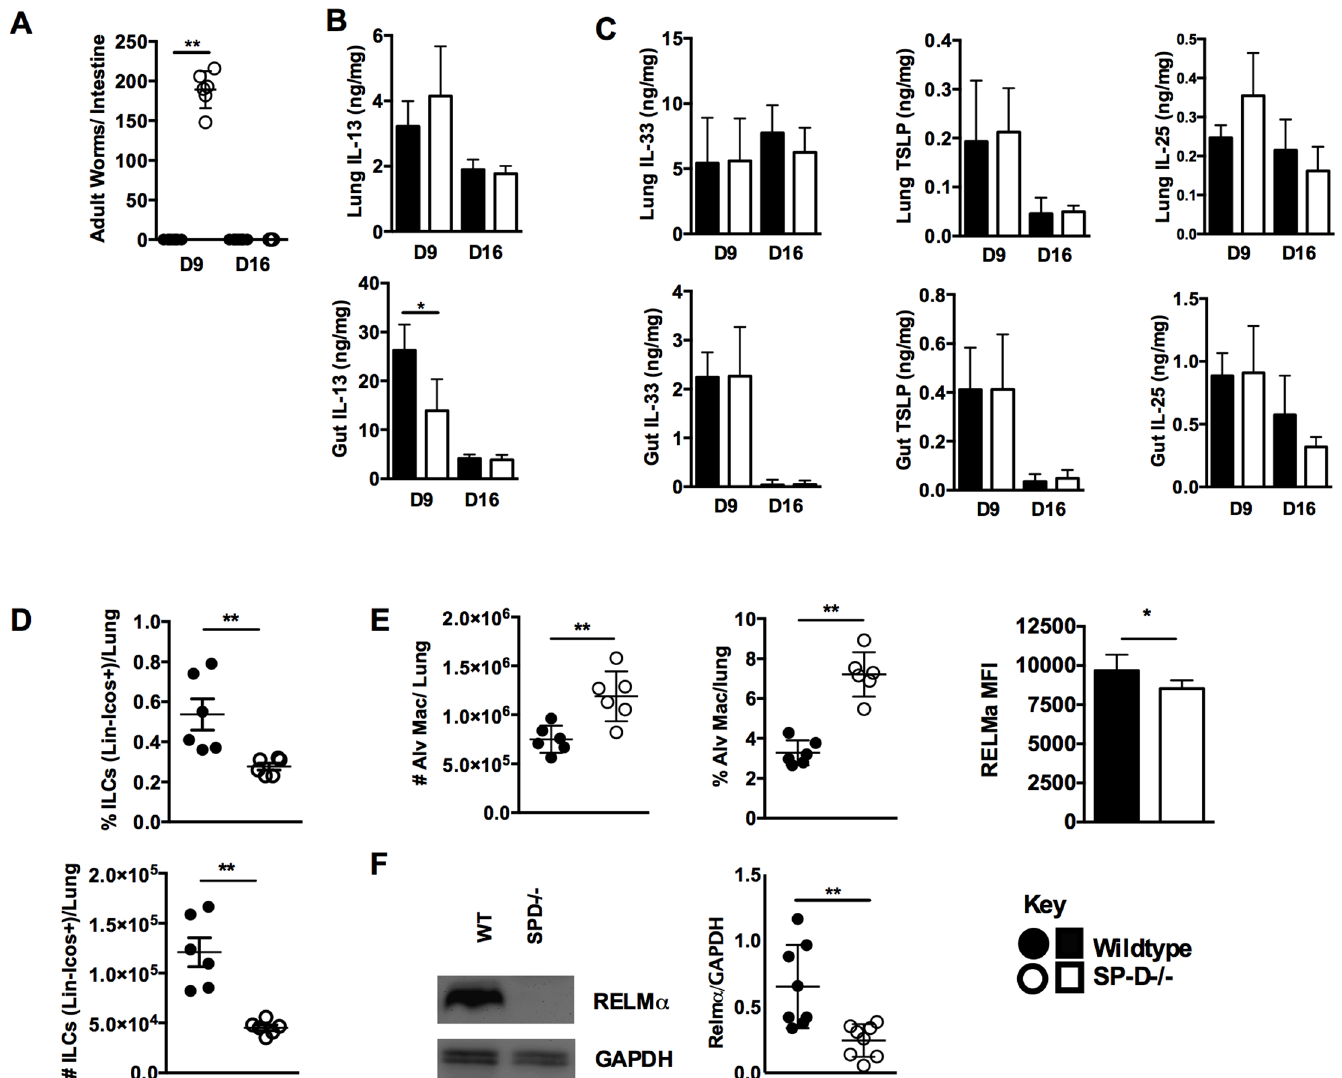
Fig 2. Immunity to N . brasiliensis is impaired in SP-D-/- mice. N . brasiliensis infected wild type and SP-D-/- mice were killed at days 9 and 16 PI. Intestinal worm burdens were quantified (a) . Levels of lung and intestinal tissue IL-13 (b) , IL-33, TSLP and IL-25 (c) were established by ELISA at days 9 and 16 PI. FACS analysis established proportions and total numbers of ILC (d) . Numbers and proportions of alveolar macrophage and mean fluorescence intensity (MFI) of RELM- α detection within this population (e). Relative concentration of RELM- α in the lungs of day 9PI WT and SP-D-/- mice was detected by Western Blot and quantified by densitometry (f). Data are representative of 2 – 3 individual experiments with N = 4 – 6 mice per group. * P < 0.05, ** P < 0.01.